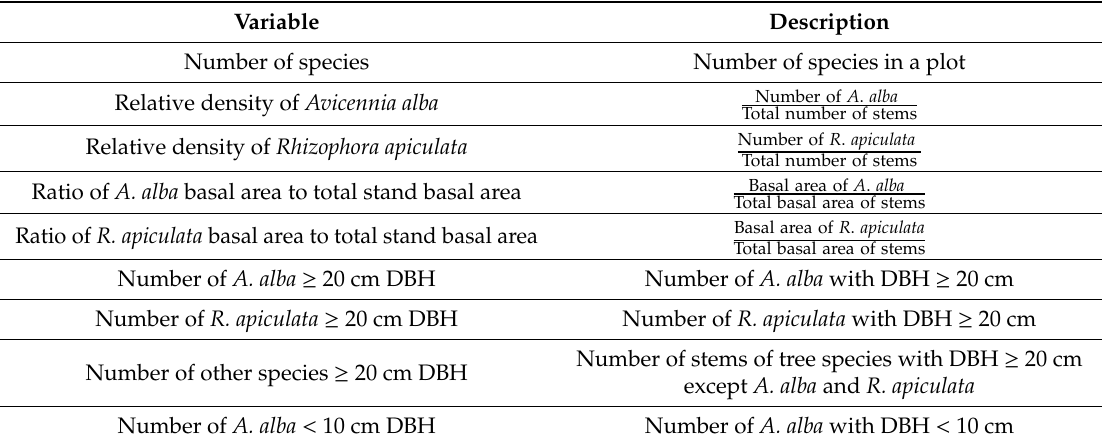
Table 2. Structural variables used for grouping plots for accretion and erosion